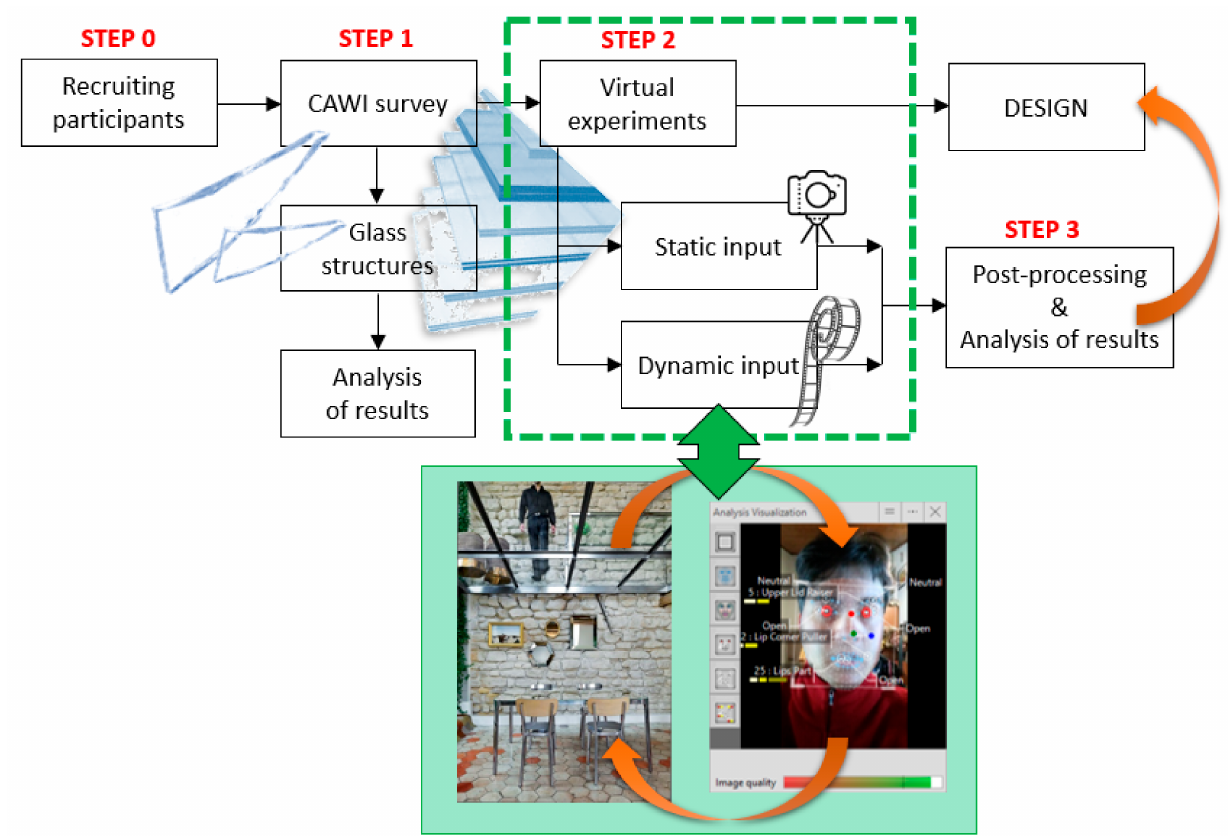
Figure 3. Flowchart of the virtual experimental analysis. A detailed example: a glazed apartment floor in Paris, FR (adapted from [30], © Jerry Jacobs Design) and facial expression analysis (© C.